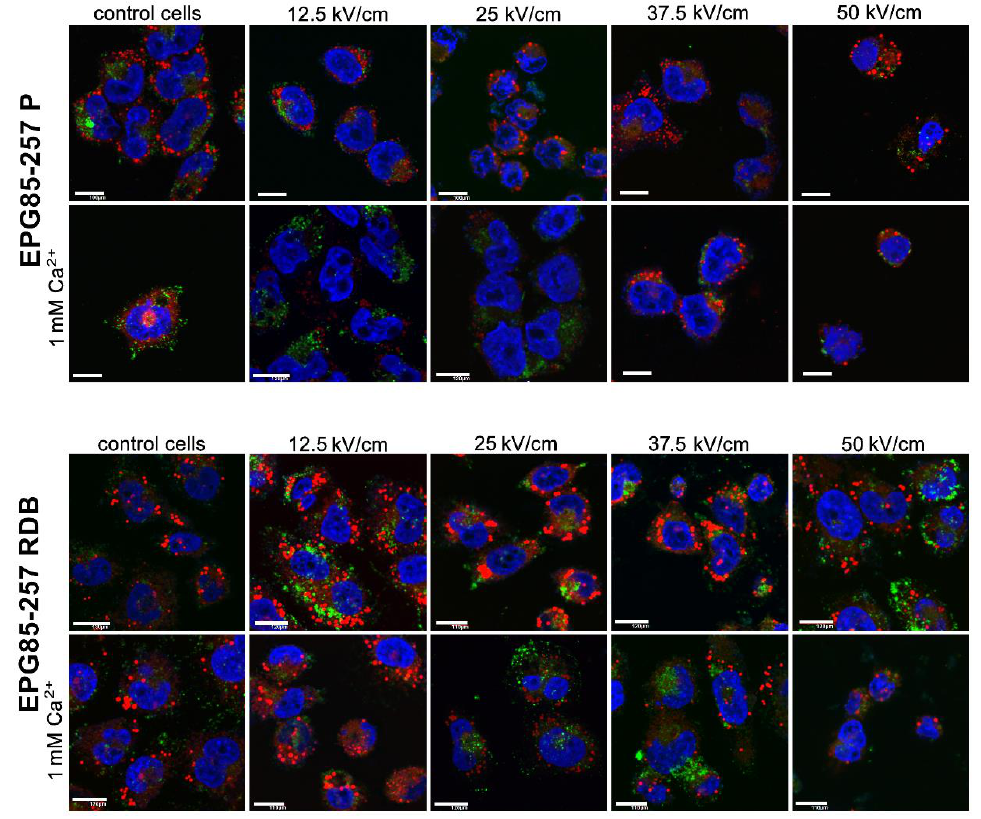
Figure 5. The evaluation of calcium by Fluo-8 green dye and lipid droplets stained by red dye LipidTOX™ Deep Red Neutral Lipid Stain, after 24 h in human gastric cells, after the exposure to nsPEFs with or without calcium ions (1 mM). Nuclei stained by DAPI blue marker.